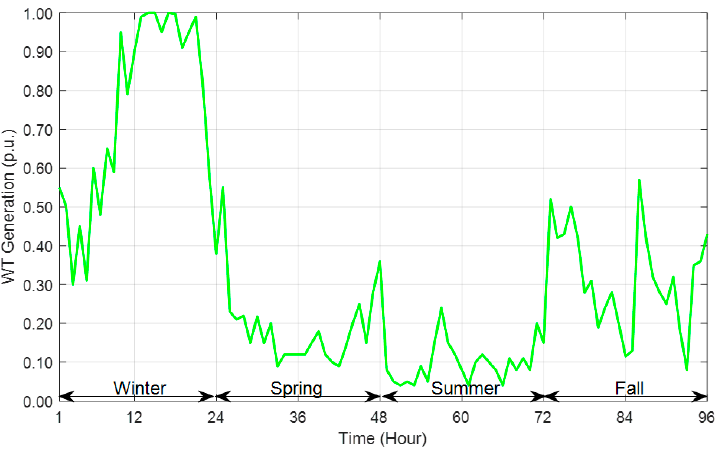
Figure 3. The seasonal variation of WTDG output power.